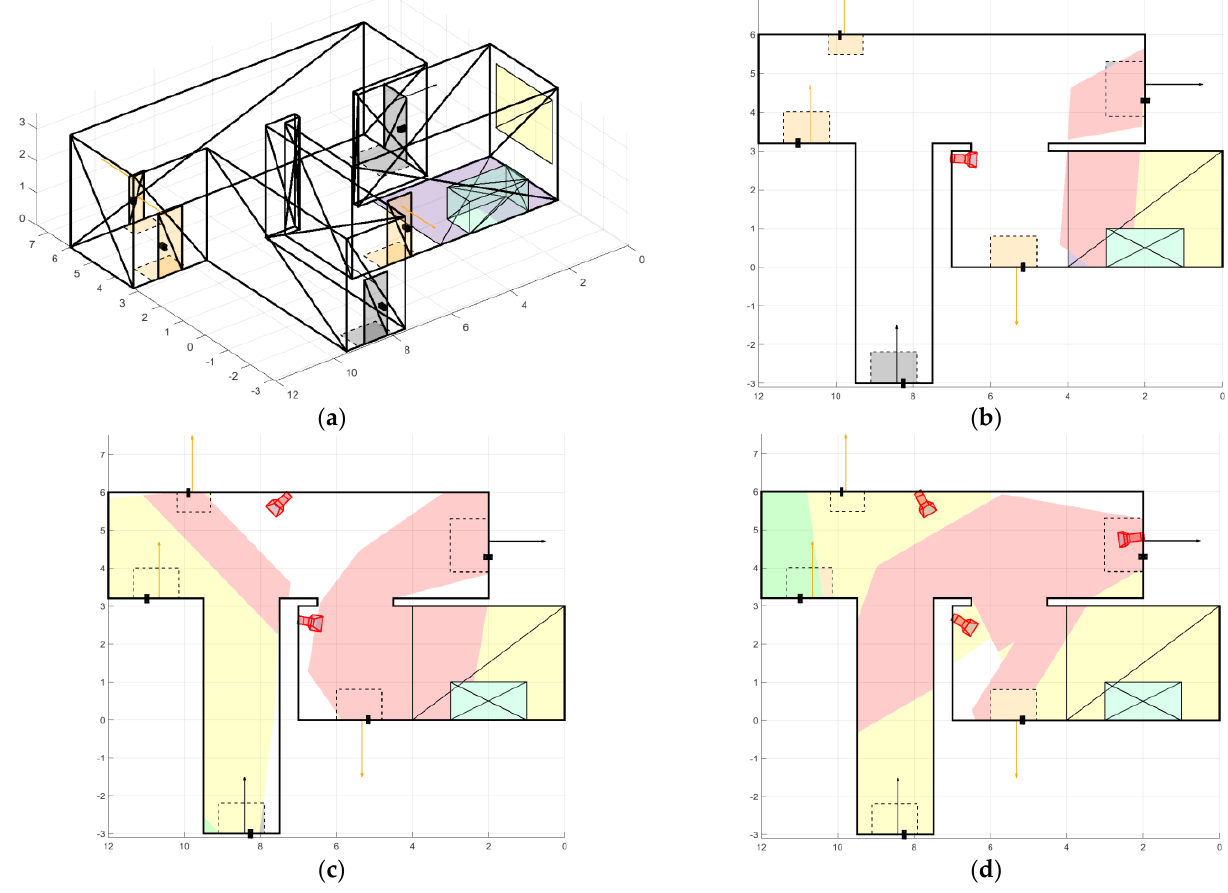
Figure 12. Placement of cameras in room 1: ( a ) room 1 model; ( b ) single camera placement; ( c ) placement of two cameras; and ( d ) placement of three cameras.